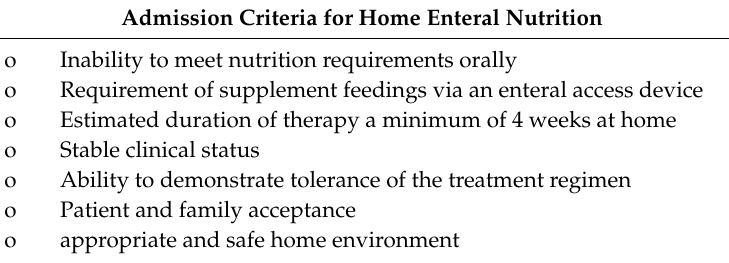
Table 1. Admission criteria for home enteral nutrition